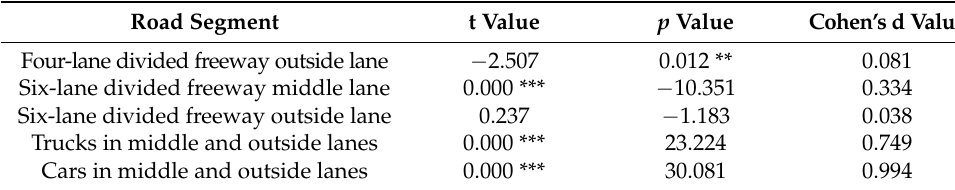
Table 5. Difference test of preferred trajectory deviation for different vehicle